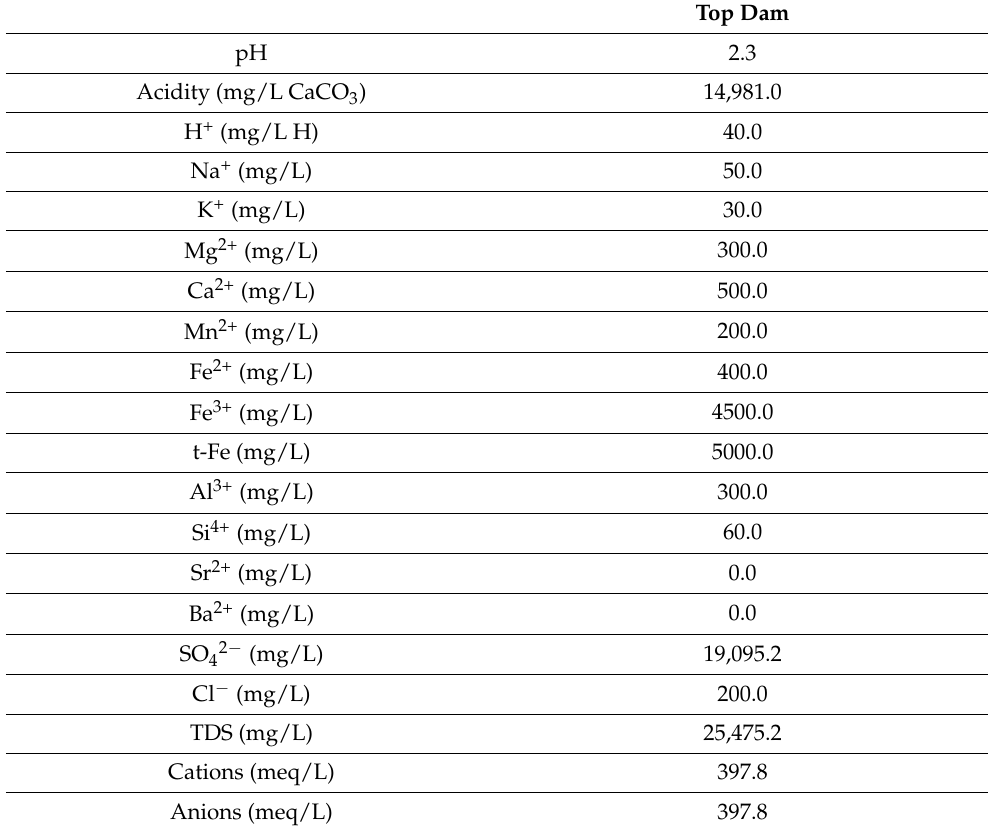
Table 1. Chemical compositions of water in the Top